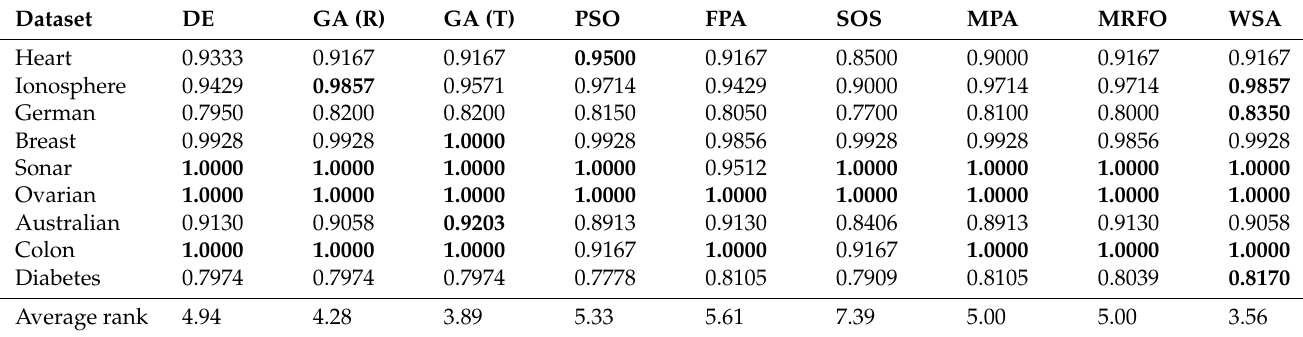
Table 5. Best classification accuracy achieved by each algorithm for each dataset.